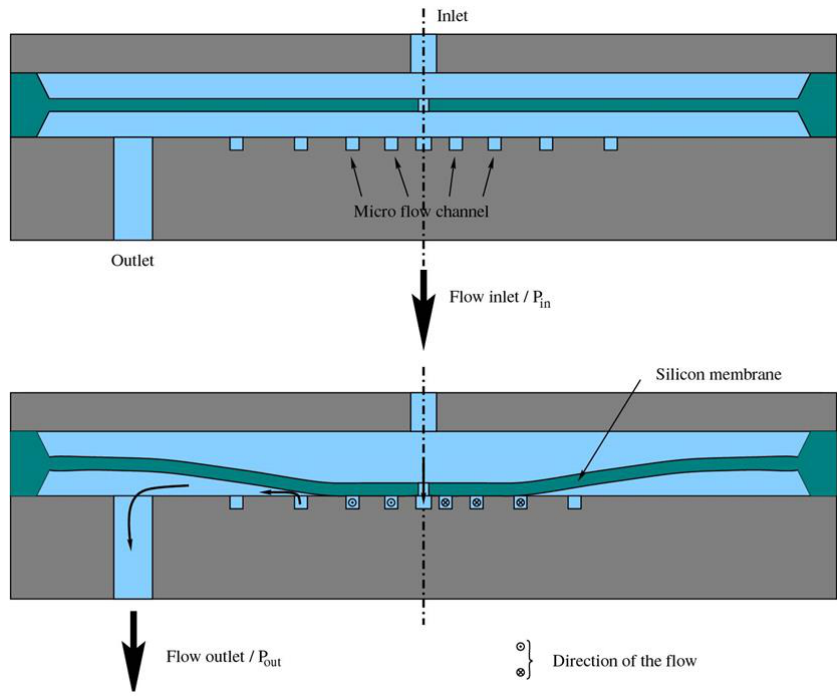
Figure 4. Cross-section of a triple-stack passive flow regulator, with a top Pyrex wafer (inlet port), a middle Si wafer (membrane), and a bottom Si or Pyrex wafer (substrate with a spiral microflow channel and an outlet port). As the pressure increases, the Si membrane deflects against the substrate and forces the fluid flow through the spiral channel. By design, the membrane covers a channel length that increases linearly with the applied pressure to maintain a constant flow rate (Courtesy of Debiotech SA, Switzerland).